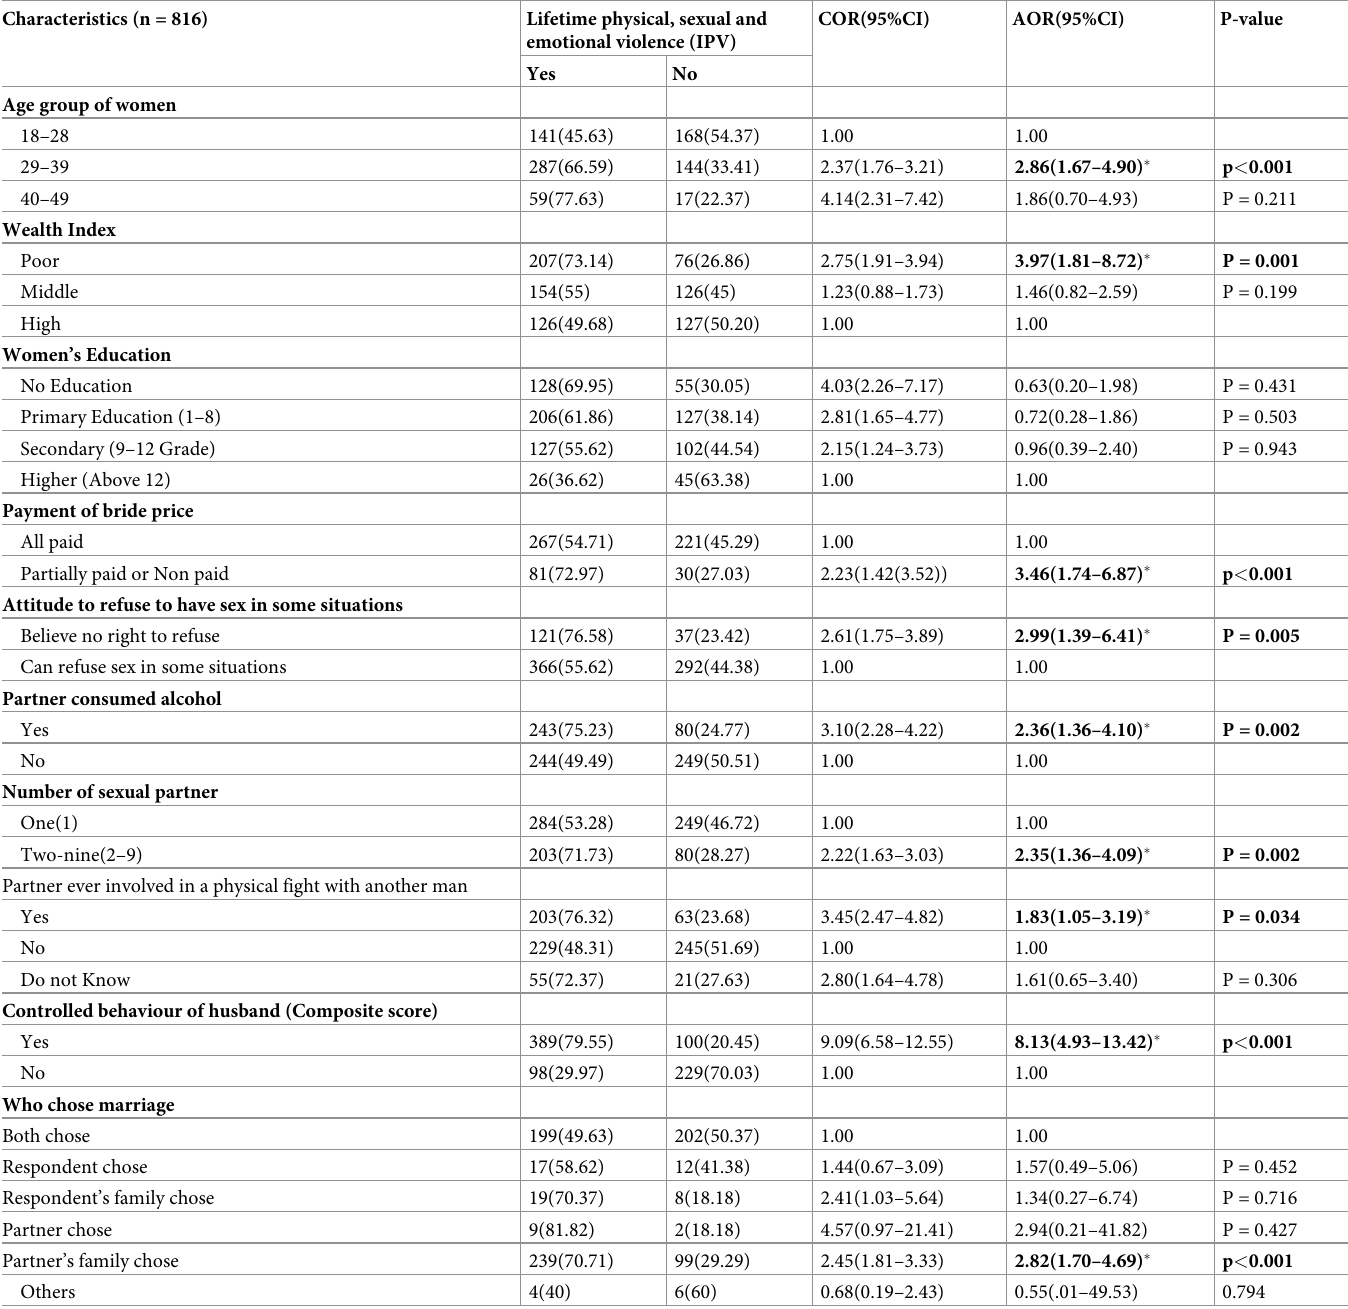
Table 5. Logistic regression model of factors associated the lifetime IPV against women living with and without HIV in Ethiopia, November-December 2018. Characteristics (n =